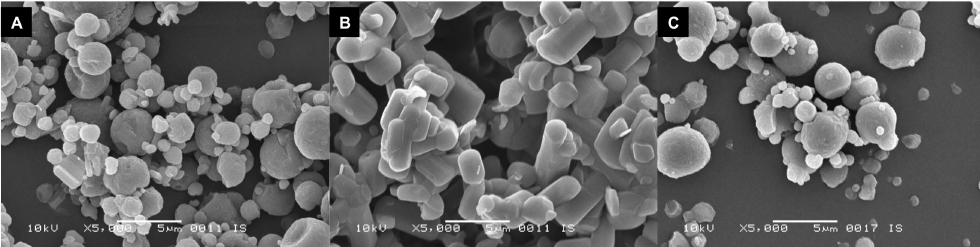
Figure 4. The powder mass retained in the Twincer ® as a function of storage time and expressed as a fraction of the total (nominal) dose ( n = 4, average ± SD). Storage RH values are displayed at the top and spray-drying inlet temperatures on the left-hand side.